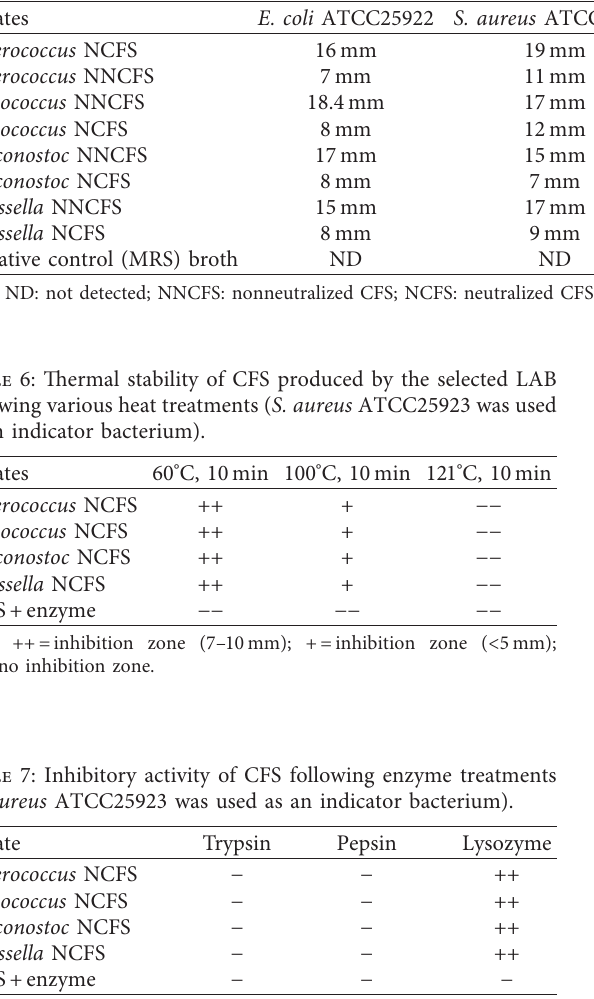
Table 5: Inhibition of various indicator organisms by CFS produced by lactic acid